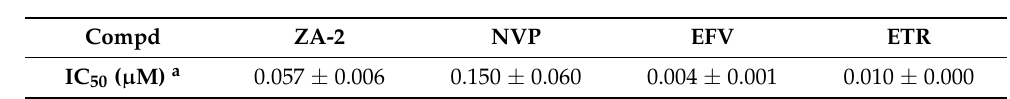
Table 2. Inhibitory activity to WT HIV-1 RT of ZA-2